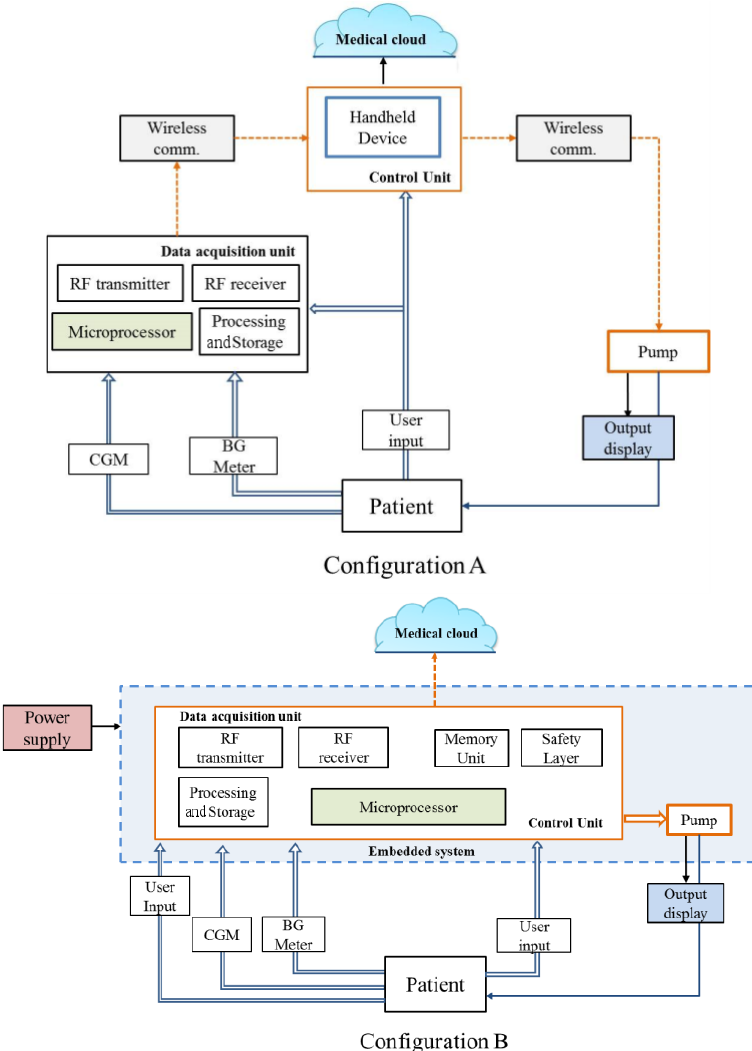
Figure 1. Schematic artificial pancreas (AP) system architecture. In Configuration A (top), the control unit is an application installed on a handheld device. In Configuration B (bottom), the embedded controller is integrated into the actuating insulin pump (BG = blood glucose; CGM = continuous glucose monitoring; RF = radio frequency).